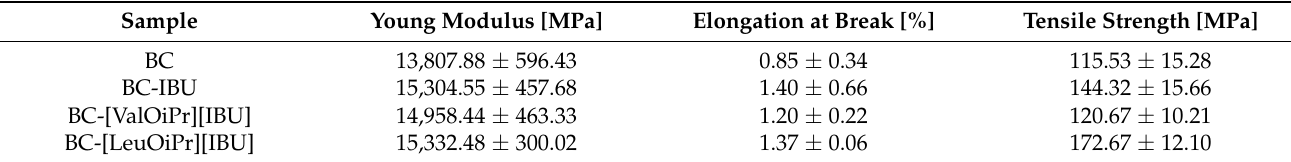
Table 1. Results of mechanical tensile assays obtained BC membranes expressed as Young modulus, elongation at break, and tensile strength. Mean values ± standard deviation, n =